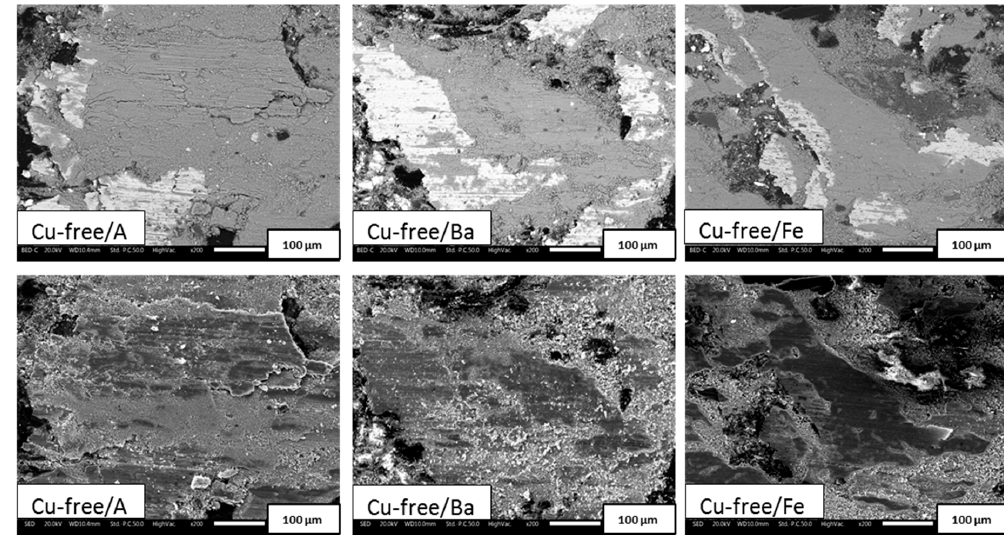
Figure 5. SEM backscattered electrons observations of worn pins’ surface.